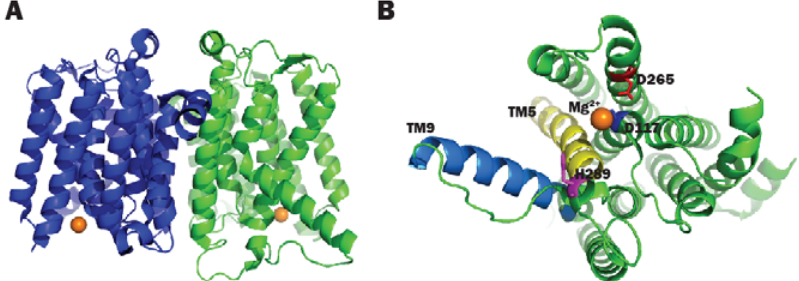
Figure 3. ( A ) 3D structure of AaMraY; ( B ) Close ‐ up view of TM5 (helix shown in blue), TM9b (helix shown in cyan), the HHH motif (shown as rainbow sticks) in loop E, the Mg 2+ (shown as an orange sphere) and the essential D265 of AaMraY. Images obtained and rendered with Pymol using 4J72.pdb.